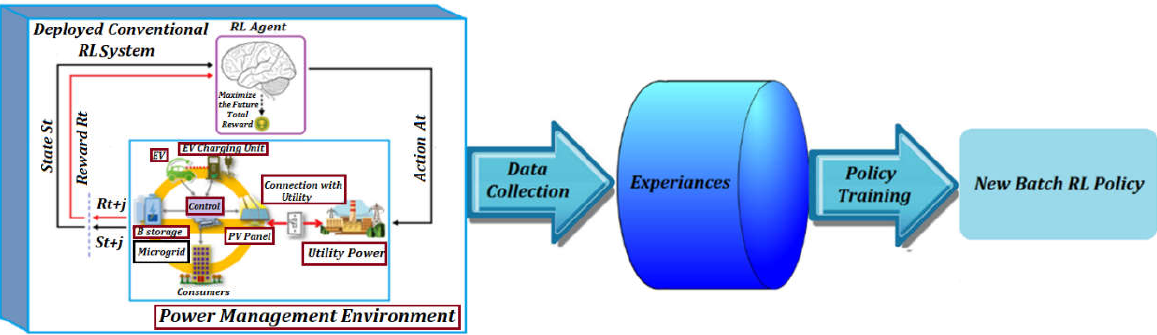
Figure 5. Batch reinforcement